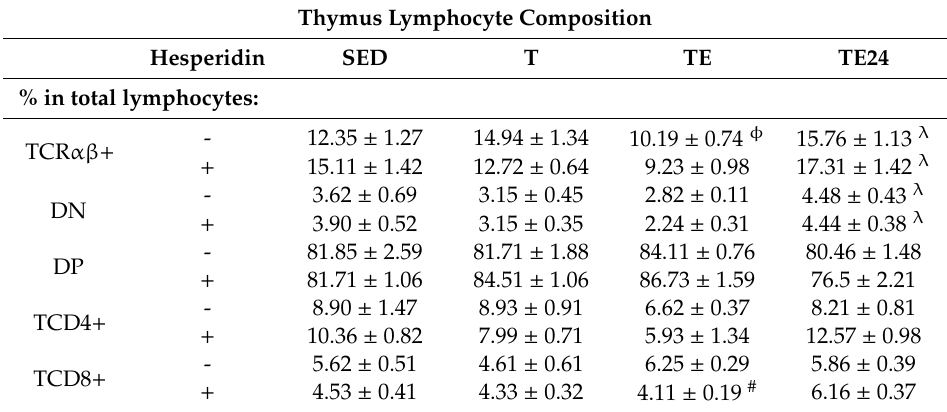
Table 1. Percentages of thymus lymphocytes: TCR αβ + ; double negative (DN) (CD4-CD8-); double positive (DP) (CD4 + CD8 + ); mature TCD4 + (CD4 + CD8-); and mature TCD8 + (CD4-CD8 + ) cells. Thymus Lymphocyte Composition Hesperidin SED T TE TE24 % in total lymphocytes: TCR αβ